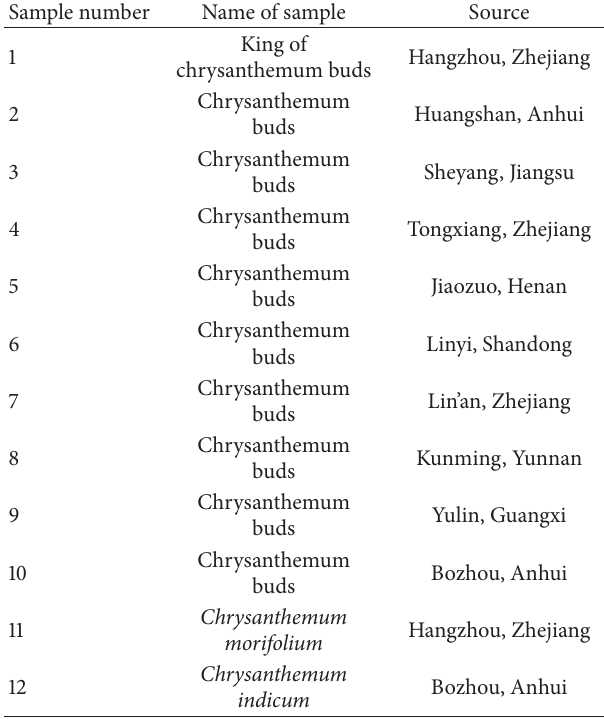
Table 1: Resource of ten chrysanthemum buds’